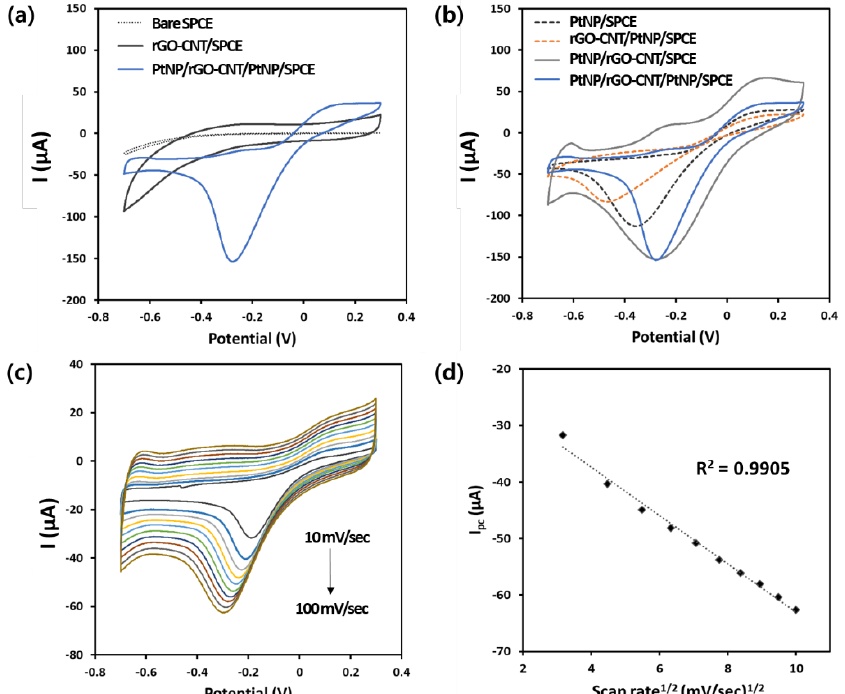
Figure3. ( a )CVcurvesofbareSPCE,rGO–CNT / SPCE,andPtNP / rGO–CNT / PtNP / SPCEinN 2 Figure 3. ( a ) CV curves of bare SPCE, rGO–CNT/SPCE, and PtNP/rGO–CNT/PtNP/SPCE in N 2 - saturated PBS solution (0.1 M, pH 7.4) containing 2.5 mM H 2 O 2 and 0.1 M KCl at a potential range